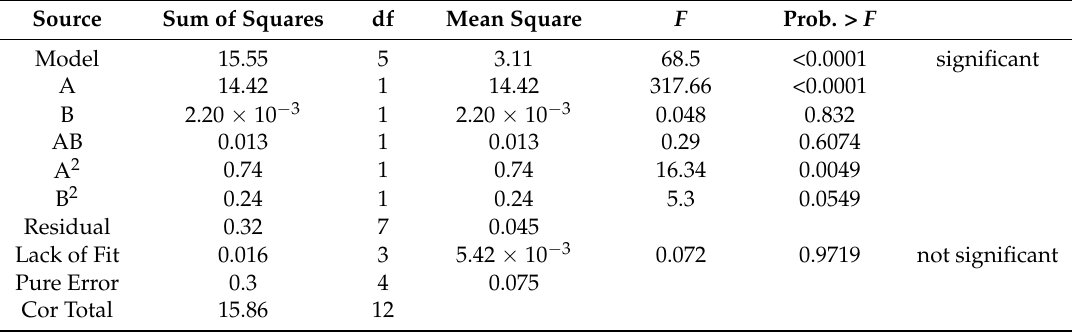
Table 6. Analyses of variance (ANOVA) for response surface model for hardness of POM composites using